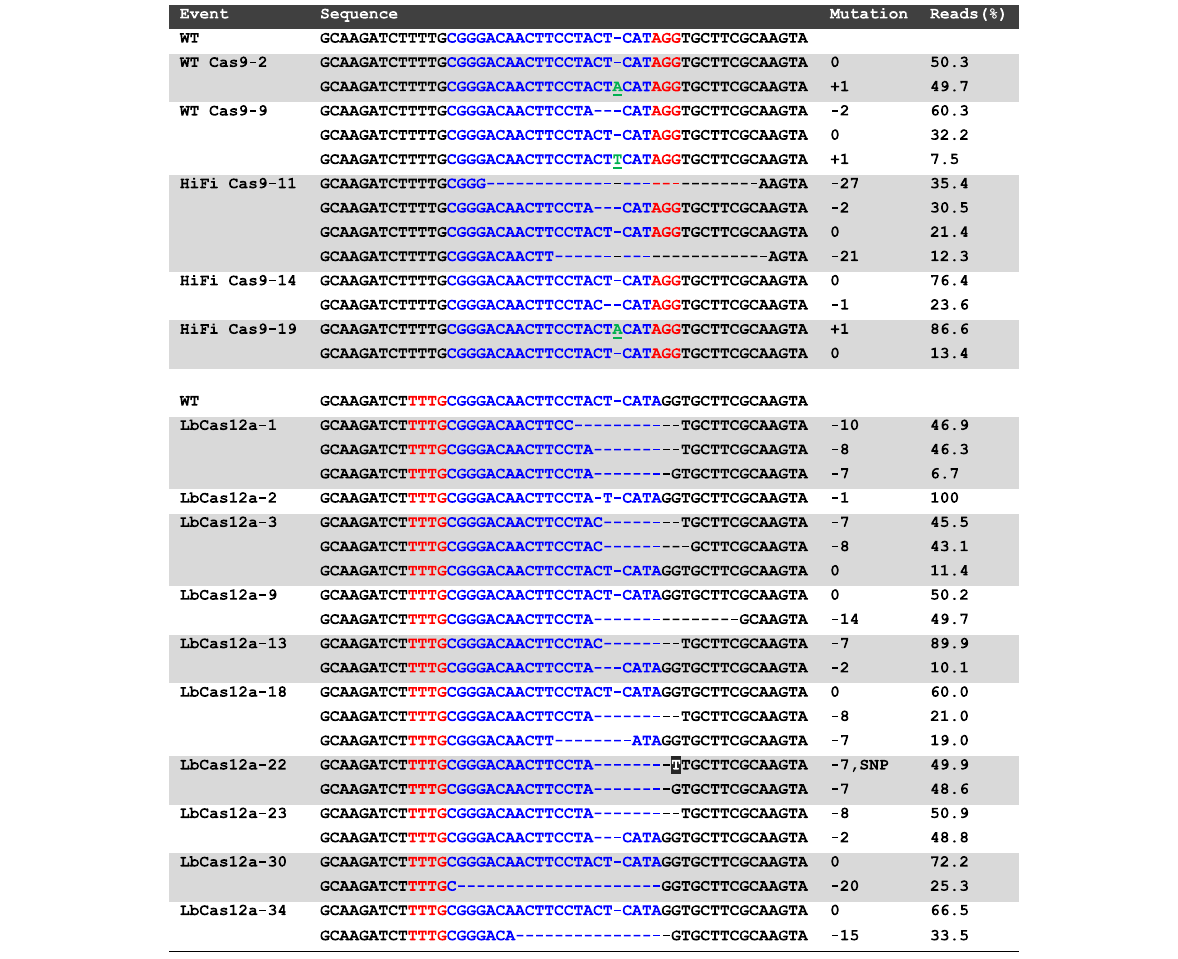
Fig. 2 NGS analysis of rice lines generated from two Cas9 (WT Cas9 and HiFi Cas9) and one Cas12a (LbCas12a) RNP complex/selectable marker plasmid co-delivery. Total reads do not always add to 100% because small percentages of low frequency reads were excluded. These low frequency events are likely due to sequencing or alignment errors. Blue letters, target sequences in PDS exon 1; Red letters, PAM sequences; White letter in black box, substitution; Green letter with underscore, insertions; WT, wild type; SNP, single nucleotide